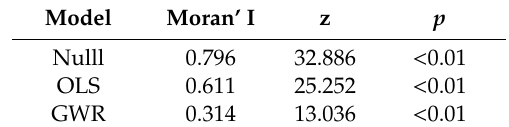
Table 5. Spatial autocorrelation test.